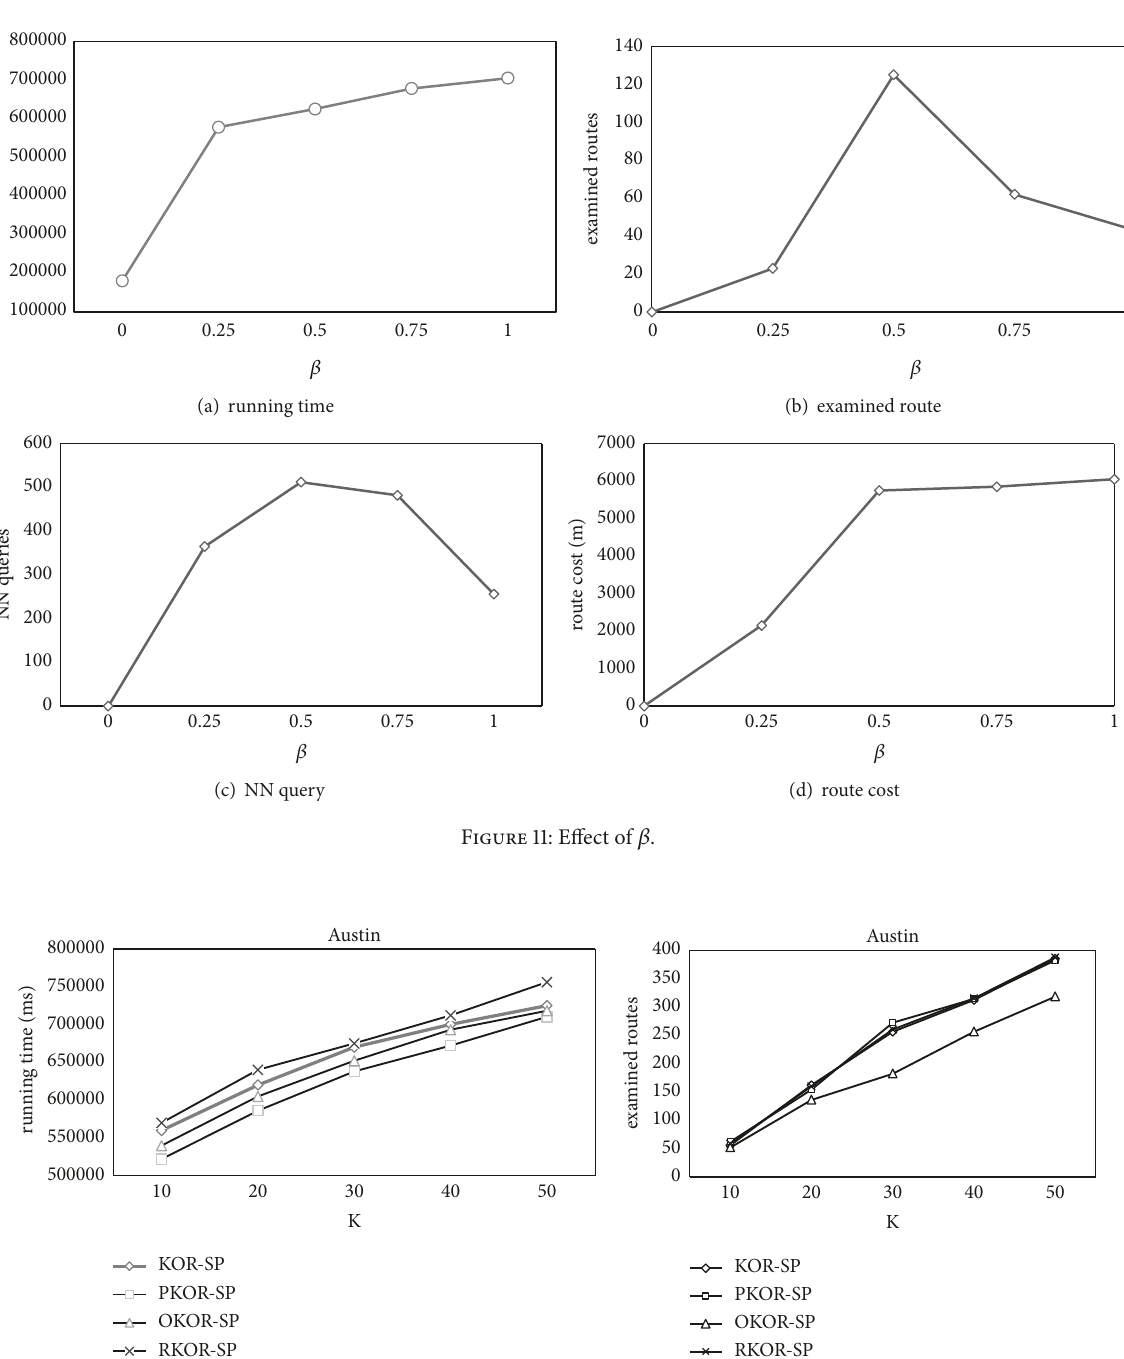
Figure 12: Performance on different KOR-SP algorithms in